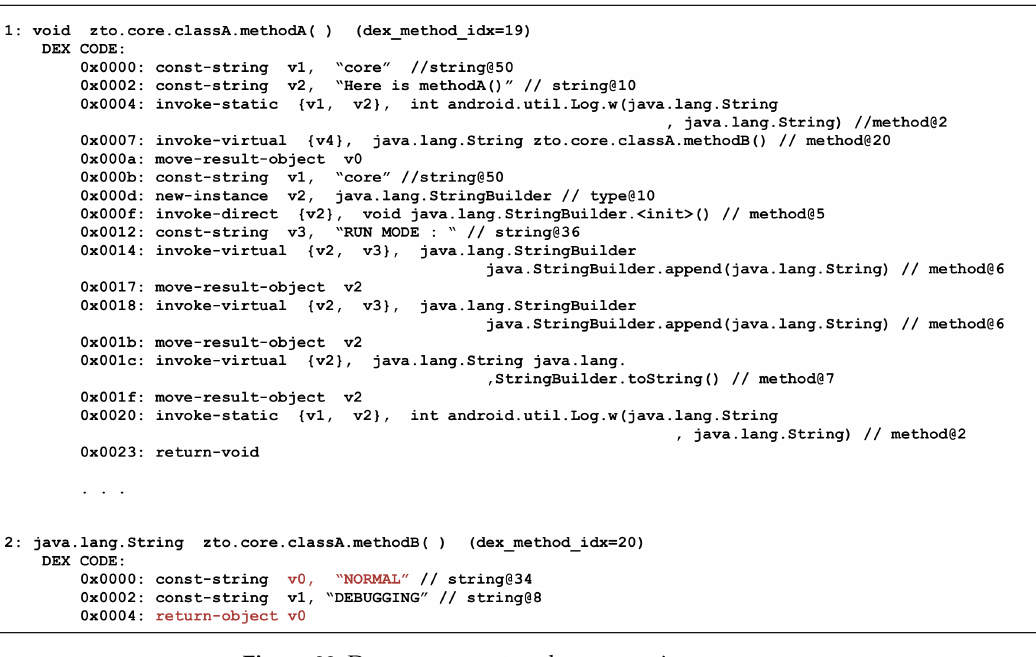
Figure 23. Dump Method A and Method B in Core OAT .